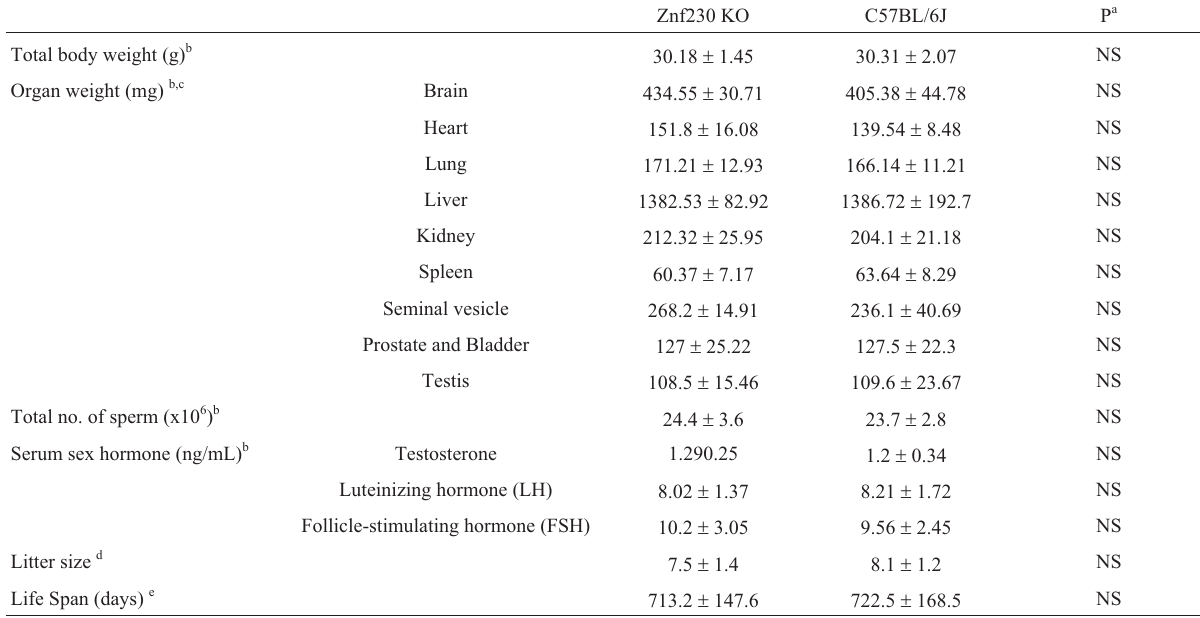
Table 1 - Comparison of phenotypes between Znf230 KO and C57BL/6J mice.